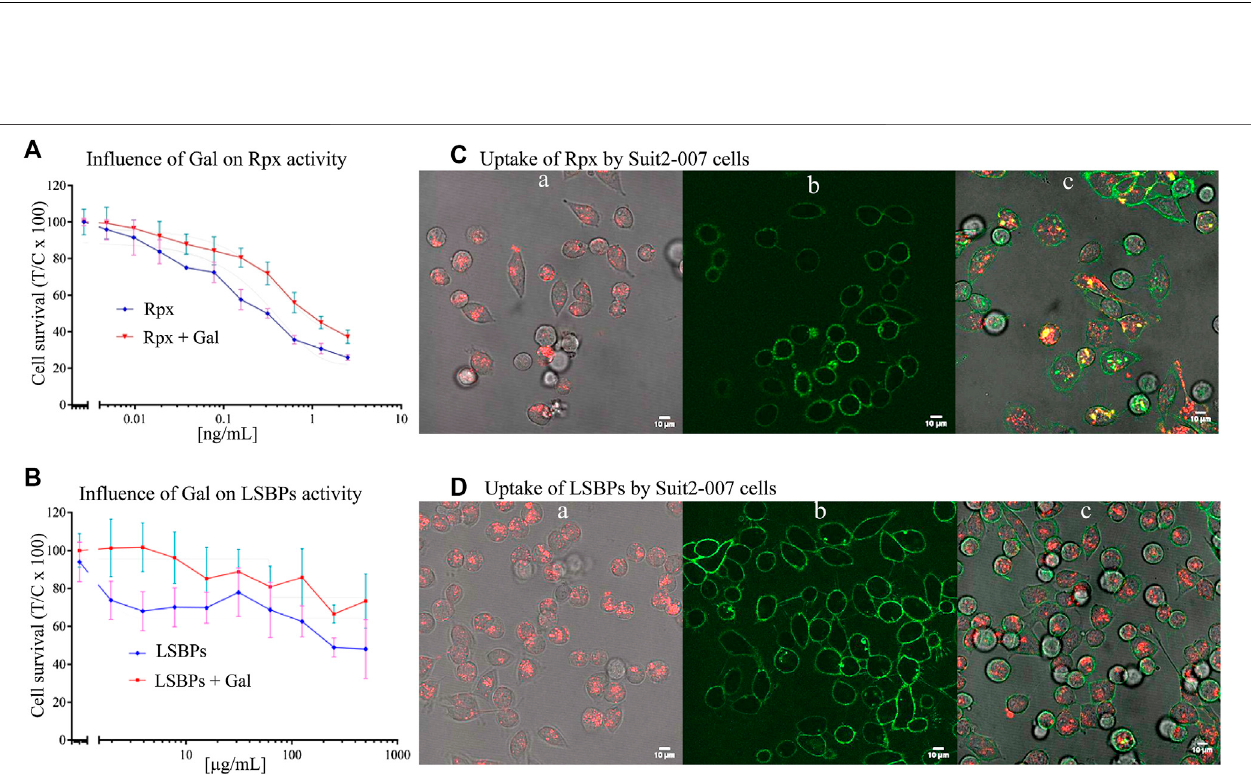
FIGURE 3 | Anti-proliferative effect of riproximin and lactosyl-sepharose binding proteins. (A,B) Represent the anti-proliferative effects of Rpx and LSBPs at 48 h, respectively, in Suit2-007 PDAC cells (blue lines). In addition, these effects were antagonized by prior incubation with galactose (red lines). (C,D) (a, b, and c) represent microscopic images of Suit2-007 cells, that were exposed to Rpx as well as LSBPs. These proteins had been labeled with the dye Alexa fl uor 647 and are indicated by red color. In addition, the Suit2-007 cells were exposed to an antibody against EpCAM, linked to the dye Alexa fl uor488, which is visualized by green color. The three corresponding images (a, b, and c) show aspects of the individual colors and their combination, respectively. Images were taken by a fl uorescence microscope at 630-fold magni fi cation (oil immersion).